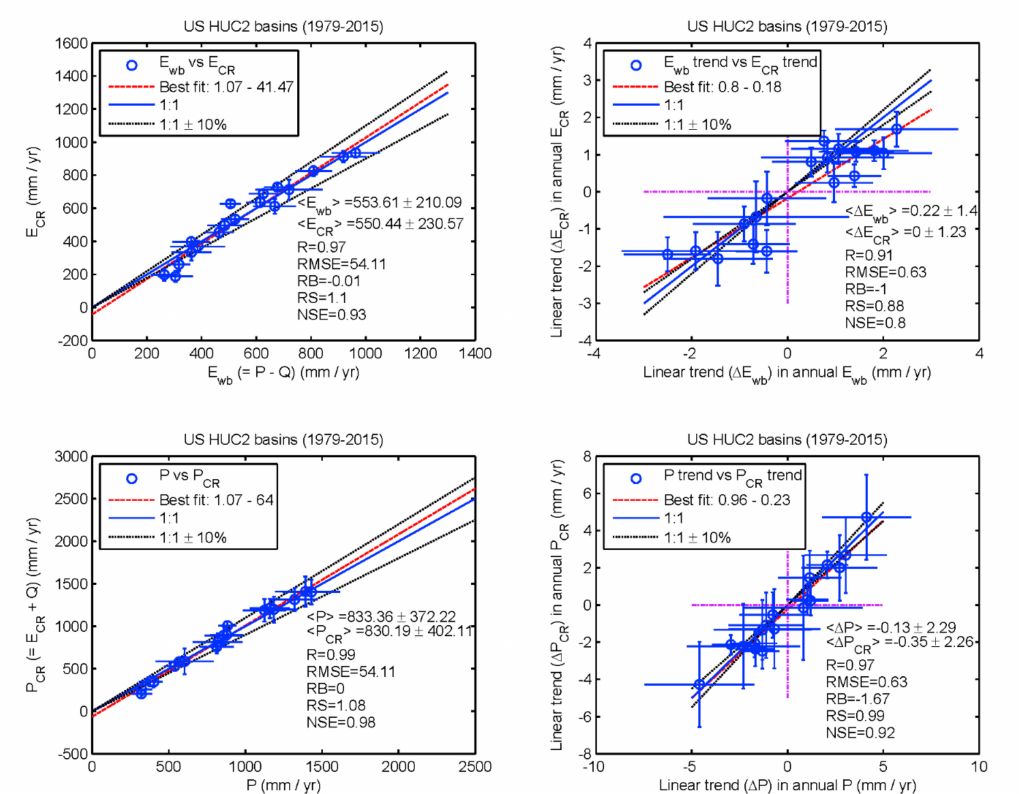
Figure 5. Regression plots of water-balance and GCR17-derived mean annual ET rates and least-squares fitted linear tendencies in their annual values (top panels); PRISM and water-balance-derived mean annualprecipitationratesandleast-squaresfittedlineartendenciesintheirannualvalues(bottompanels) for the HUC2 basins of the conterminous US. The whiskers denote the standard deviation of the annual values for the means (left panels) and the standard error in the estimated trend values (right panels). The sharp bracket denotes an arithmetic sample ( n = 18) mean. See the text for explanation of the statistical